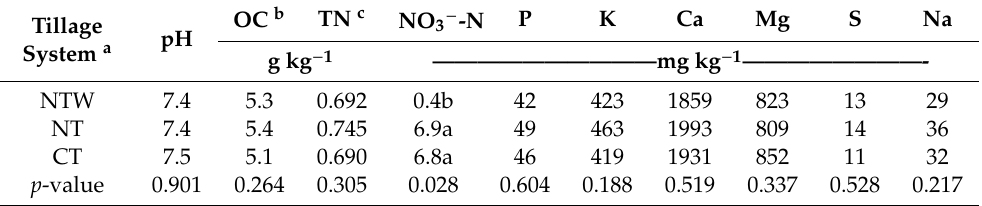
Table 1. Soil characteristics of samples collected at a depth of 0–15 cm following cover crop termination in April 2016 (previously reported by McDonald et al.,